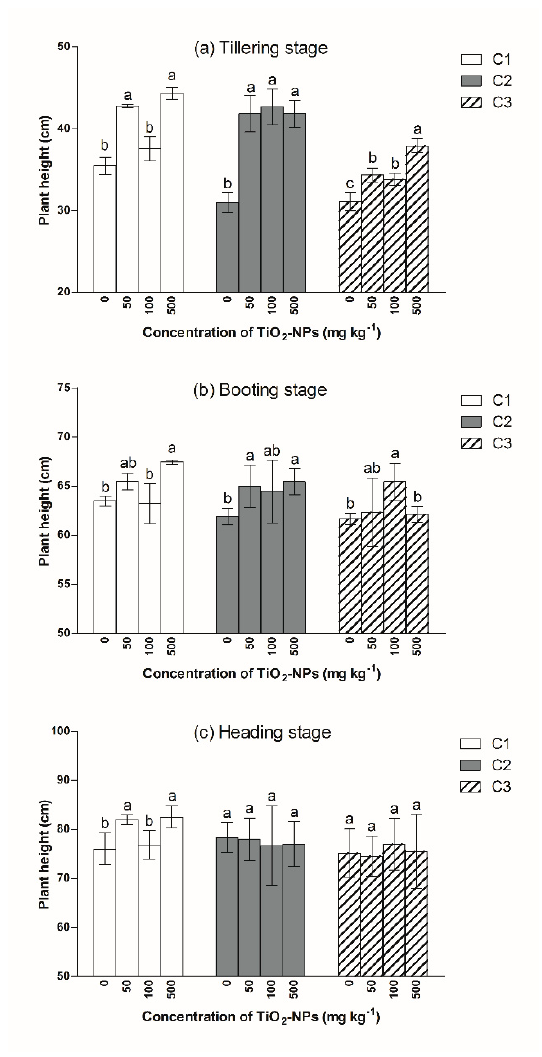
Figure 1. Plant height during various growth stages: ( a ) tillering stage, ( b ) booting stage, ( c ) heading stage. Different letters above column indicate significant difference ( p < 0.05) between various treatment in same group.